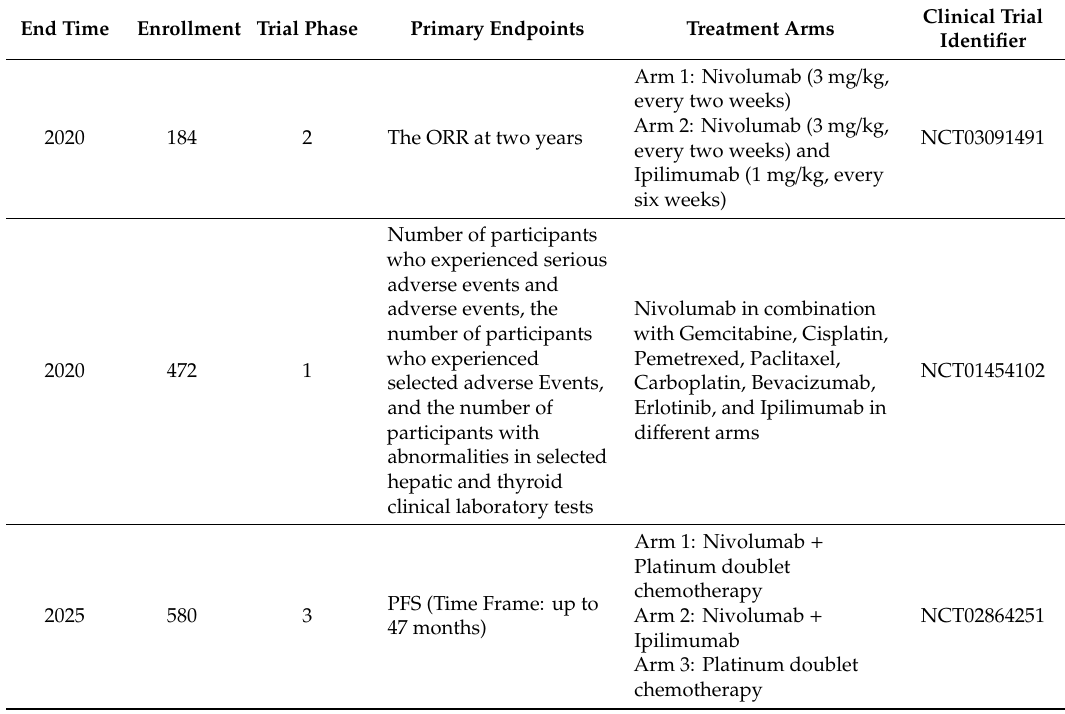
Table 5. Ongoing (until January 2020) clinical trials of ipilimumab plus nivolumab in NSCLC. End Time